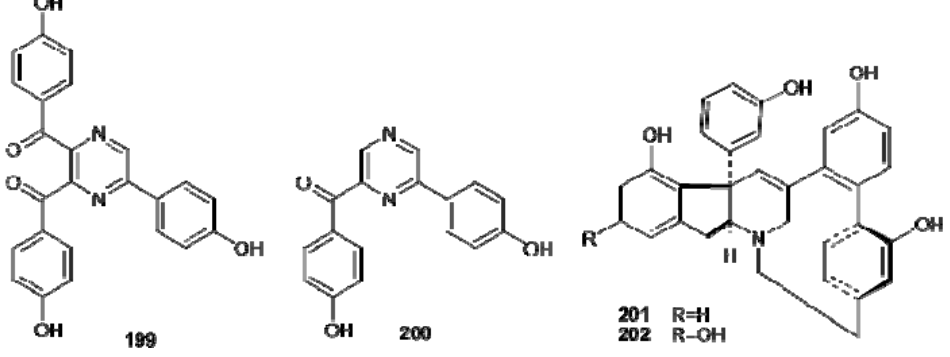
Figure 22. Structures of botryllazines ( 199–200 ) and haouamines ( 201–202